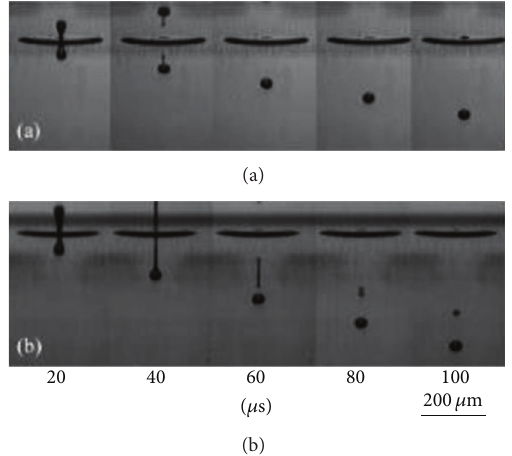
Figure 16: Comparison of (a) PEDOT and (b) F8 ink droplets [94].